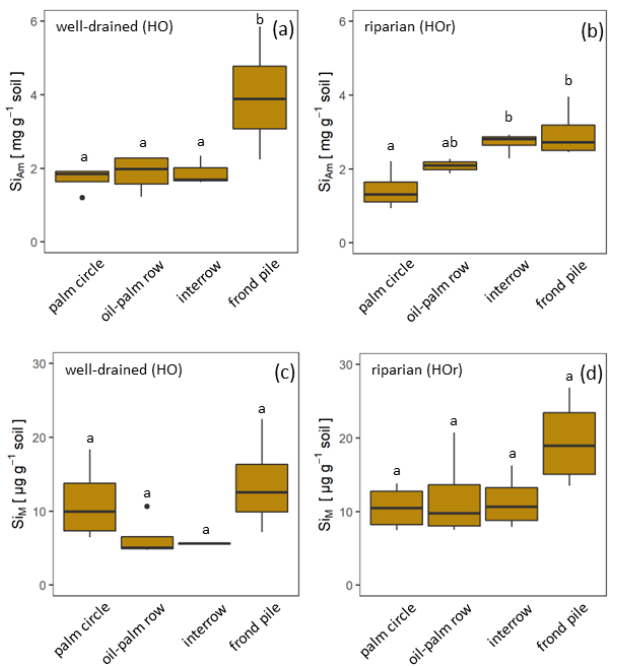
Figure 2. Concentrations of mobile Si (Si M ) and Si in amorphous silica (Si Am ) in topsoils of four different management zones: palm circles ( n = 4), oil-palm rows ( n = 4), interrows ( n = 3), and below frond piles ( n = 4) on smallholder oil-palm plantations in two differ- ent landscape positions with differing water regimes (well-drained and riparian). Boxes indicate interquartile ranges and whiskers ex- tend 1.5 times the interquartile range below or above the box. If lower-case letters (a, b) differ from one another, this indicates a significant difference between management zones within a water regime ( p ≤ 0 . 05). The Si concentrations were calculated with one- way analysis of variance (ANOVA) and Tukey–Kramer post hoc